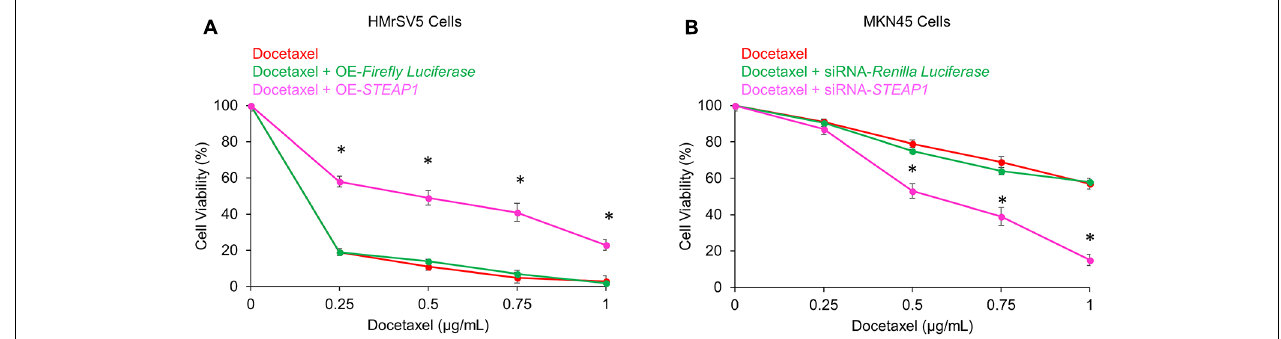
FIGURE 4 | Modulation of STEAP1 expression changes susceptibility to docetaxel treatment. (A) Firefly luciferase or STEAP1 overexpressing HMrSV5 cells were treated with indicated doses of docetaxel 72 h. (B) MKN45 cells transiently transfected with siRNA targeting Renilla luciferase or STEAP1 were treated with indicated doses of docetaxel for 72 h. MTT assay was performed to assess the cell viability after 72 h. Data was obtained from three independent replicates experiments and was represented as mean ± standard deviation (SD). ∗ p <